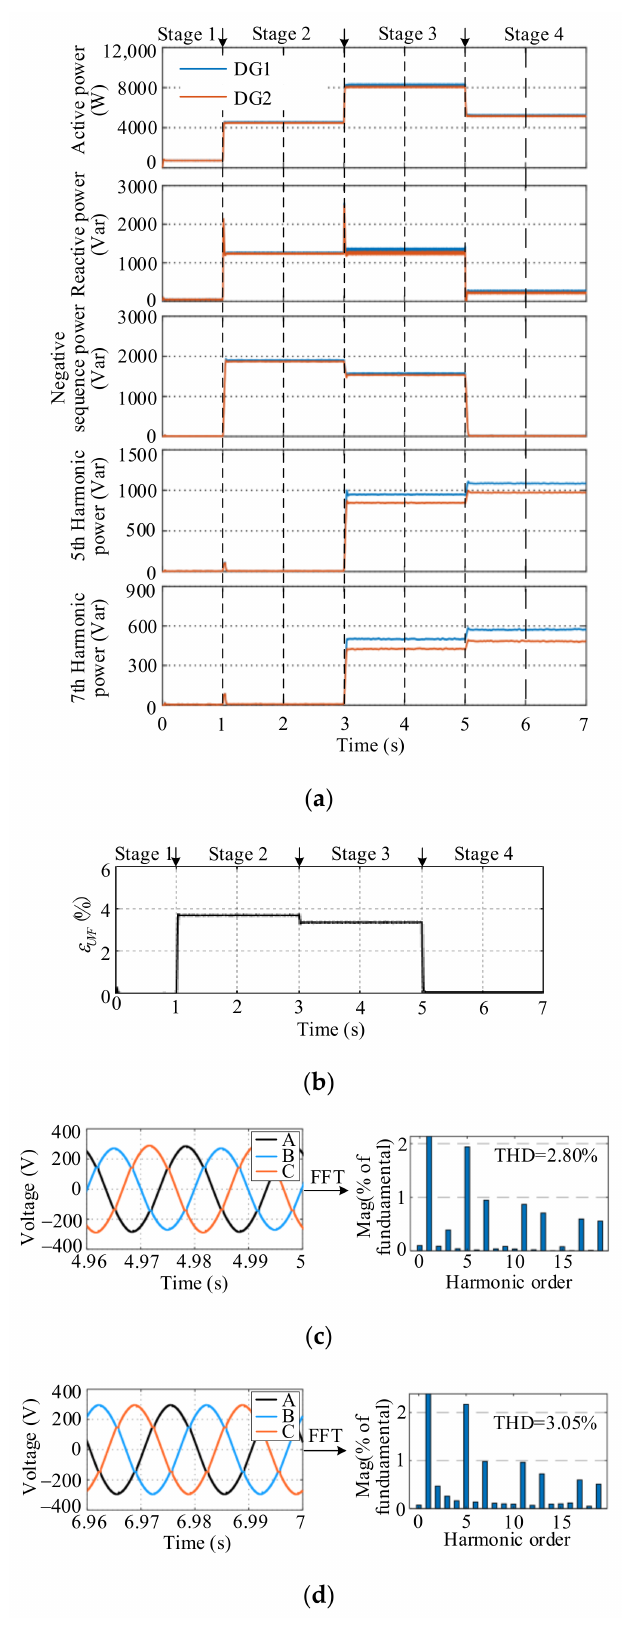
Figure 8. Traditional virtual impedance droop control: ( a ) power-sharing performance; ( b ) PCC three-phase voltage unbalance ε UVF ; ( c ) PCC voltage and A-phase voltage FFT analysis in stage 3; ( d ) PCC voltage and A-phase voltage FFT analysis in stage